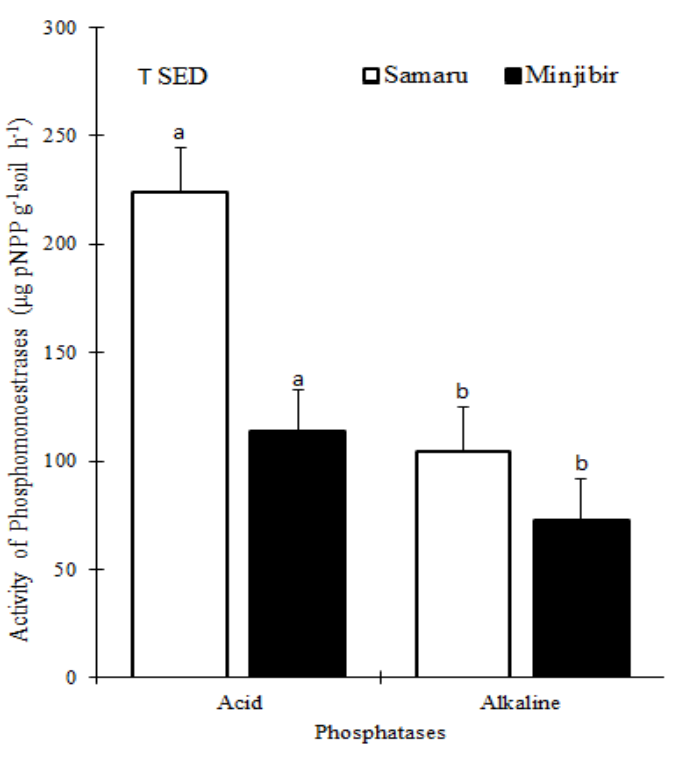
Figure 2. Activity of phosphomonoesterases across the two